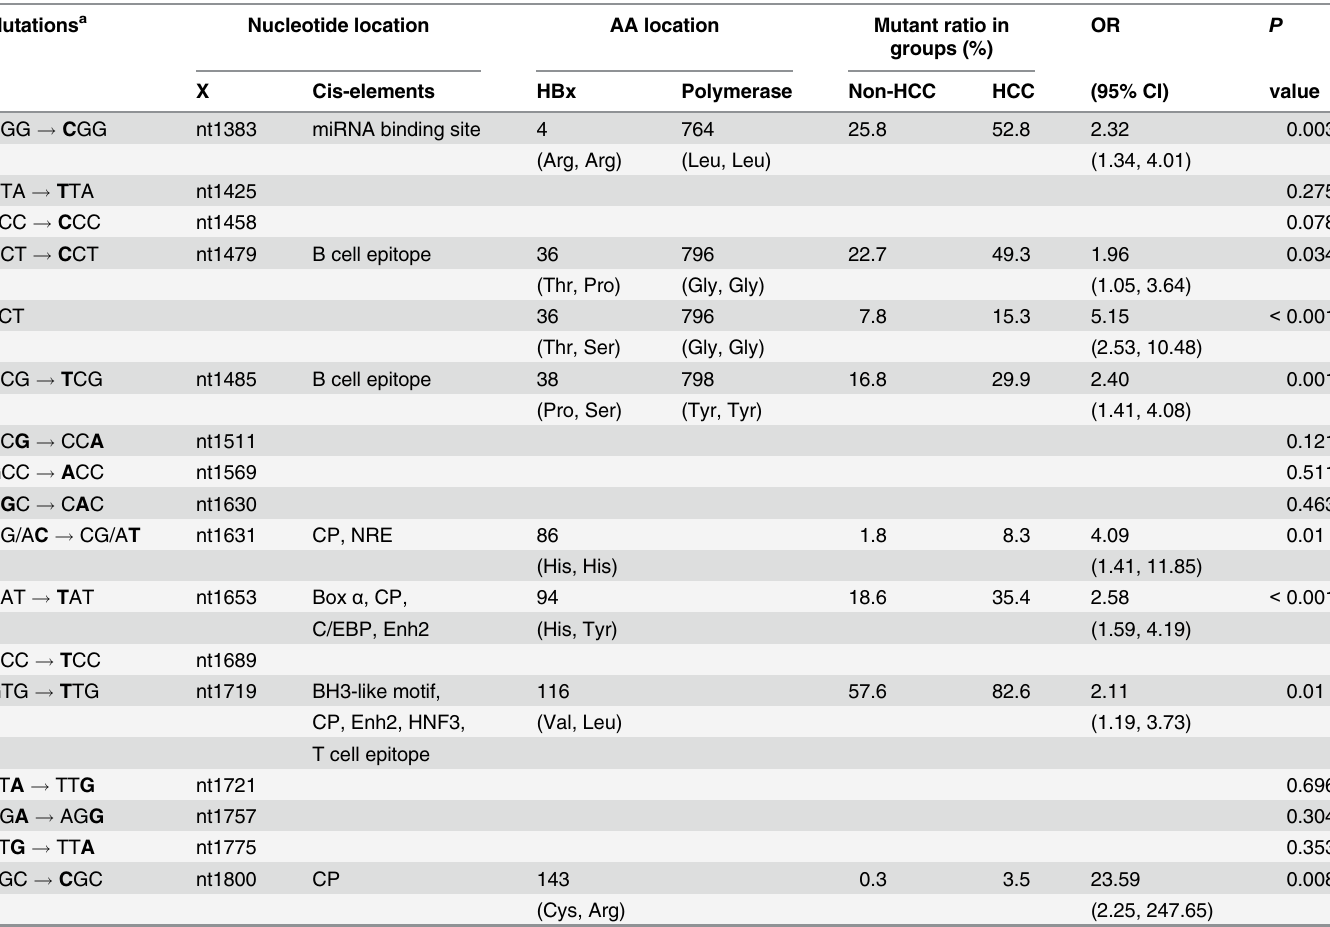
a Mutated nucleotides are shown in